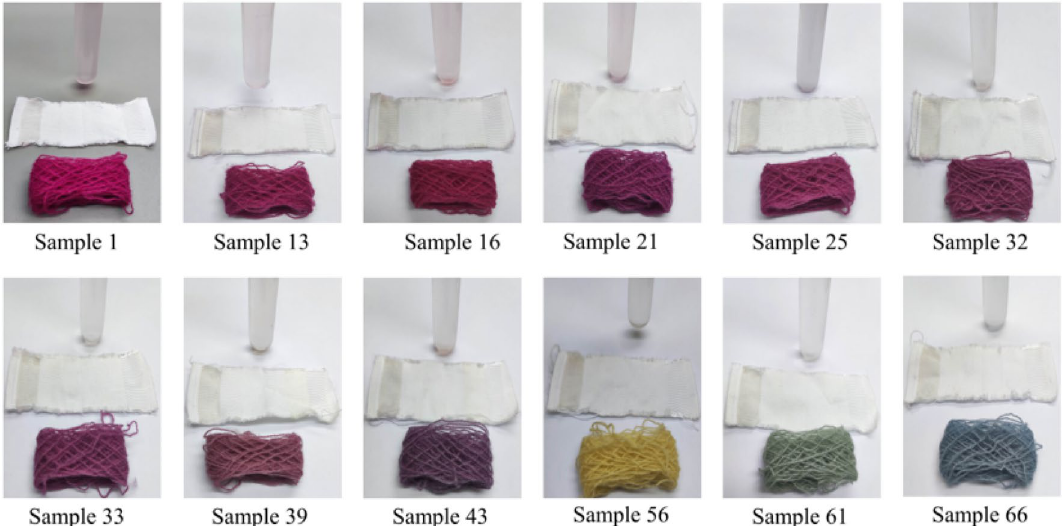
Figure 14. Wash colorfastness assessment of dyed wool yarns using singe dye, binary dye mixtures, and ternary dye